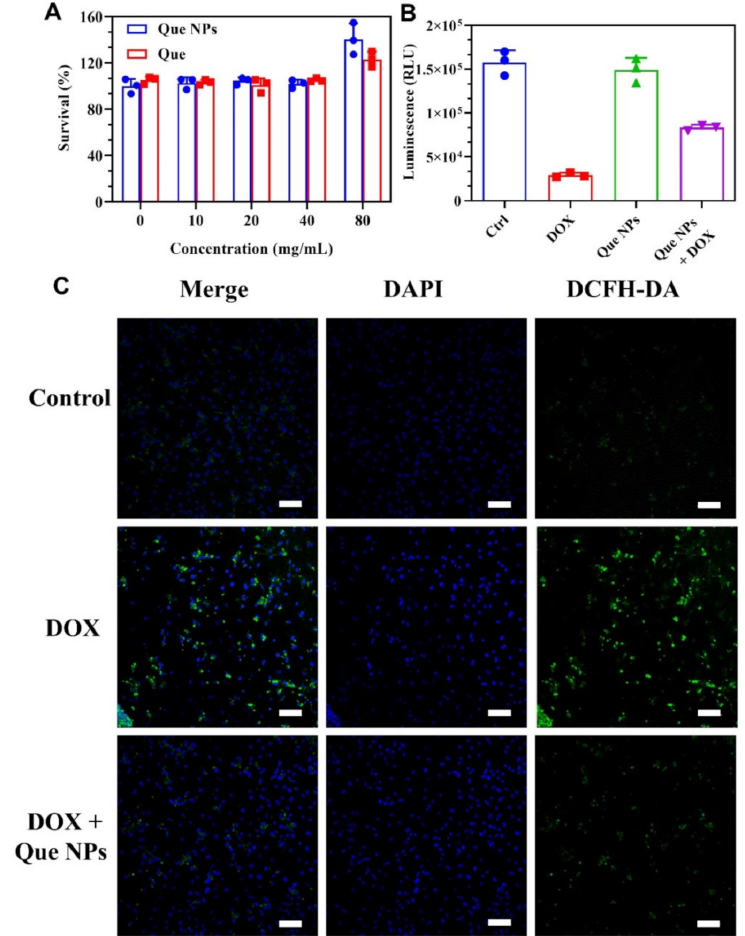
Figure 2. Assessment of the in vitro biocompatibility and protective effect of Que NPs on AC16 cells: ( A ) the cytotoxicity of AC16 cells with different concentrations of Que NPs was assessed by MTT after 24 h of culture; ( B ) the protective effect of AC16 cells with Que NPs was assessed by cell-counting life; and ( C ) the level of ROS was measured by DCFH-DA probe (scale bar, 100 µ